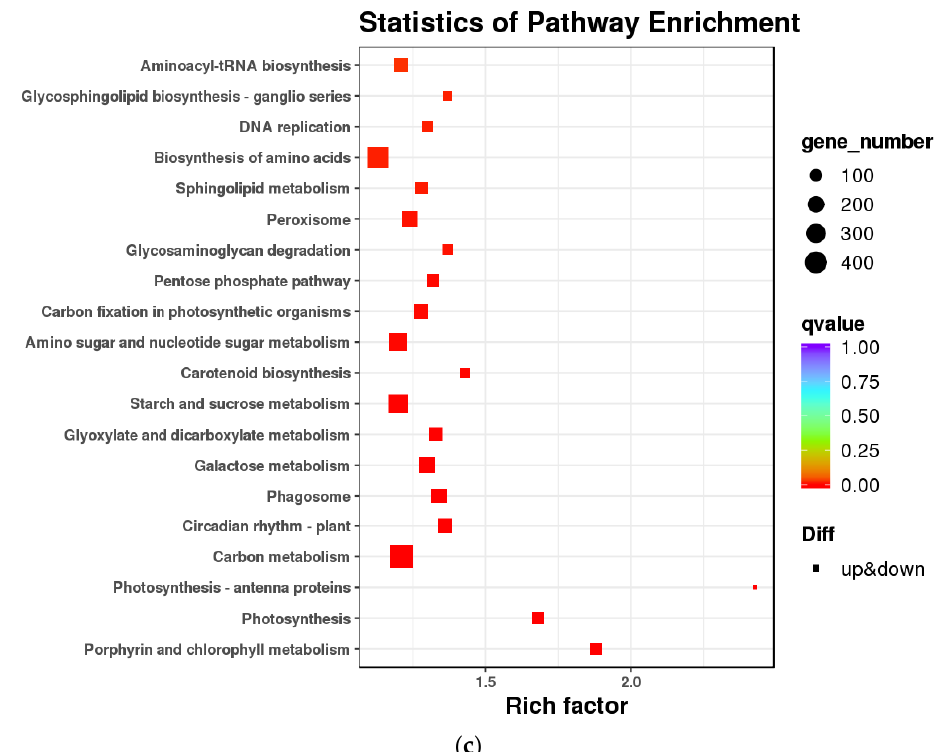
Figure 4. Enrichment scatters plot of differentially expressed genes in the KEGG pathway. ( a ) mRO vs. mLO; ( b ) mRO vs. mSO, ( c ) mSO vs. mLO. mOR, mOS, and mOL represent mature roots, mature stems, and mature leaves, respectively.